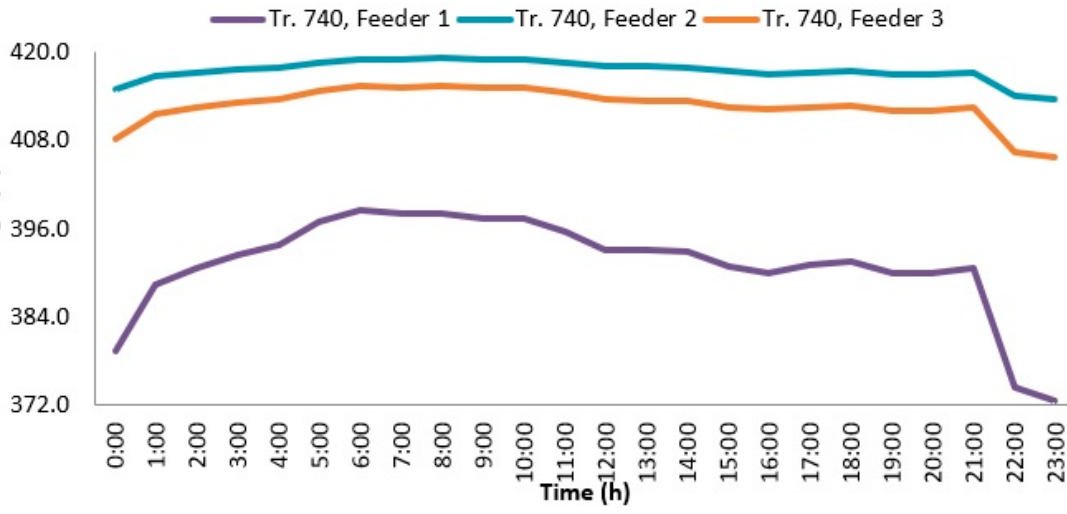
Figure 18. Voltage profiles at the end of Transformer 740 in summer with 60% EVC & off-peak charging. 3.3. Case C: Other Coordinated Charging Scheme by Applying Dynamic Response to the System Critical Hours Figure 19 shows the load profiles on Feeder 1/Transformer74 with/without response to the critical hours at a 60% EVC load penetration level compared to the case without EVs. It is clear that, during critical hours (18:00 to 22:00), the uncontrolled EVC load is shifted to less critical hours, thus largely reducing the system peak to the base profile. It is worth remembering that the response to critical hours primarily depends on charging flexibility, i.e., it has to be within driver behavior limits and not cause inconven- ience. Consequently, the substantial load reduction during critical hours, when applying the proposed model, indicates that EV charging has enough flexibility to respond to criti- cal hours without interrupting the driver behavior boundaries. Figure 20 shows a com- parison of voltage profiles—obtained using the EV load model—with and without re- sponse to the critical hours. It is clear that the voltage profile is maintained in order to be similar to the base case without EVs, compared with the uncontrolled charging strategy. With respect to the application of the proposed model, the results of load and voltage